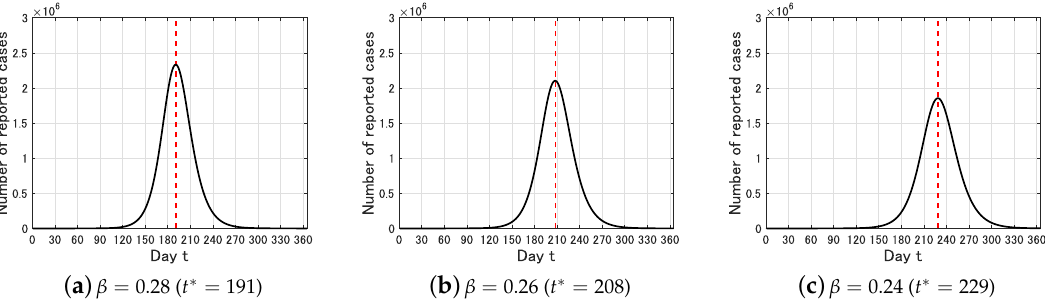
Figure 2. Time variation of the number Y ( t ) of infective individuals who are identified at time t (0 ≤ t ≤ 365) for p = 0.1. The dot lines represent the epidemic peak t ∗ .